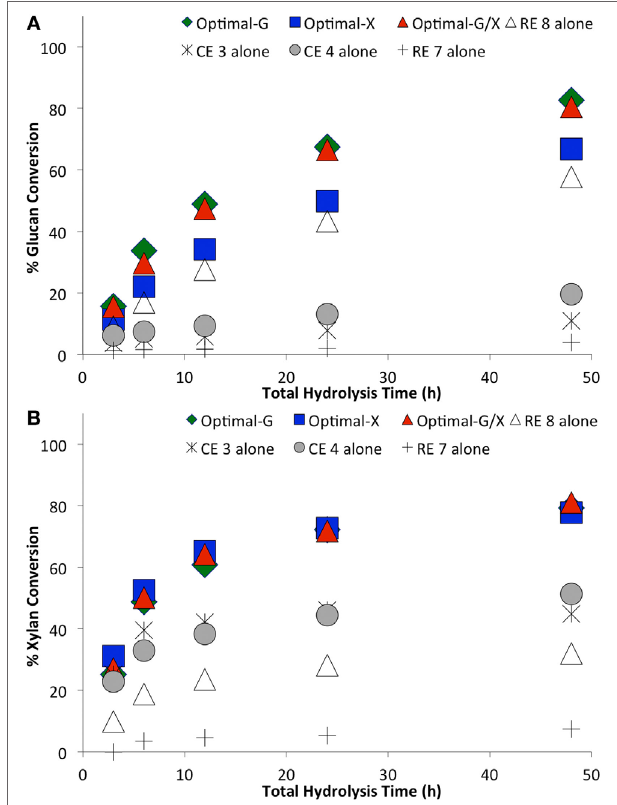
FigUre 6 | comparing optimal versus non-optimal commercial enzyme (ce) combinations on glucan-to-glucose (a) and xylan-to- xylose (B) percent conversions for ammonia fiber expansion-treated corn stover as a function of hydrolysis time . Total protein loading was 7.5 mg/g glucan. Optimal G, optimal X, and optimal G/X represent enzyme combinations that gave the highest glucose, xylose, and total sugar (glucose + xylose) yields, respectively. Mean values are reported here, while SDs in all cases was less than 2% and is not shown here for sake of